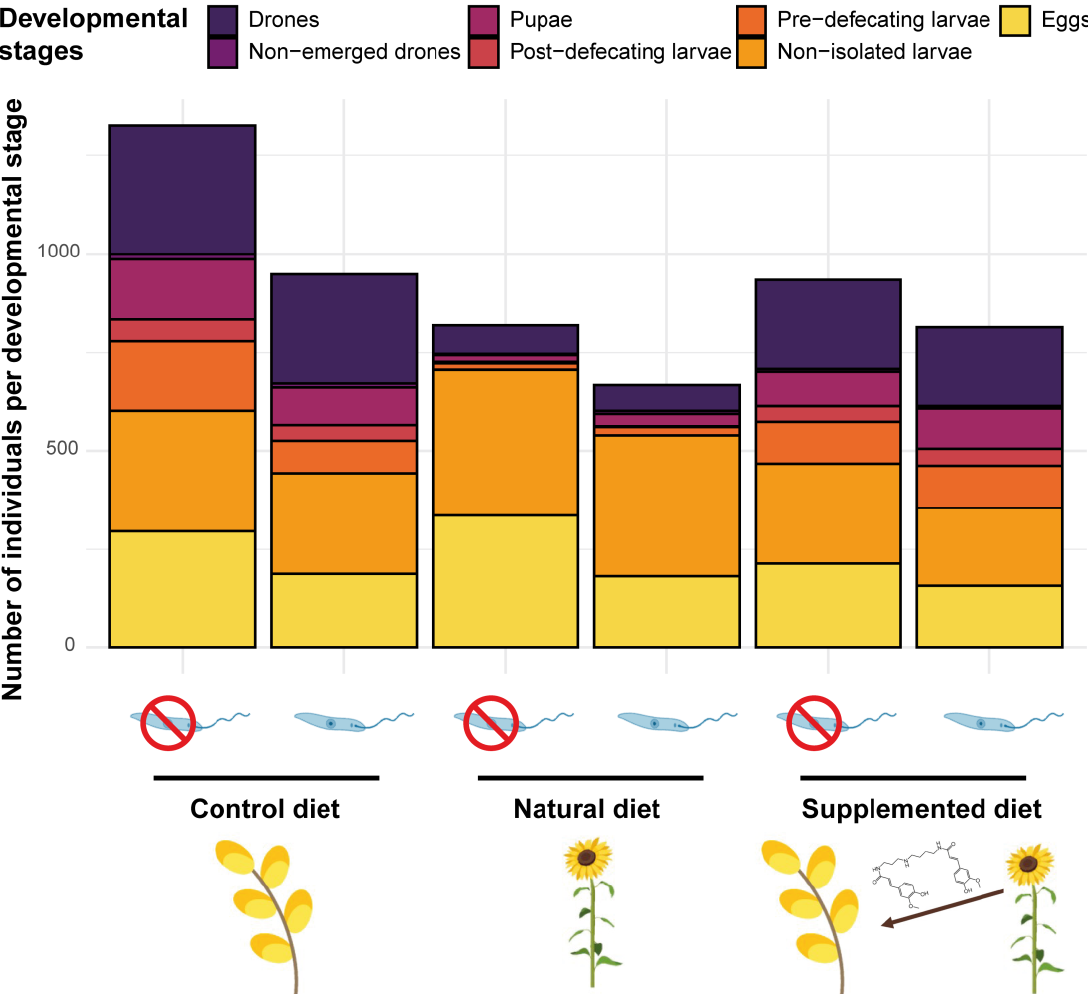
Figure 4. Microcolony development across treatments. Compilation of the brood composition of all microcolonies (n = 15) in the different treatments after 35 days of the experiment.